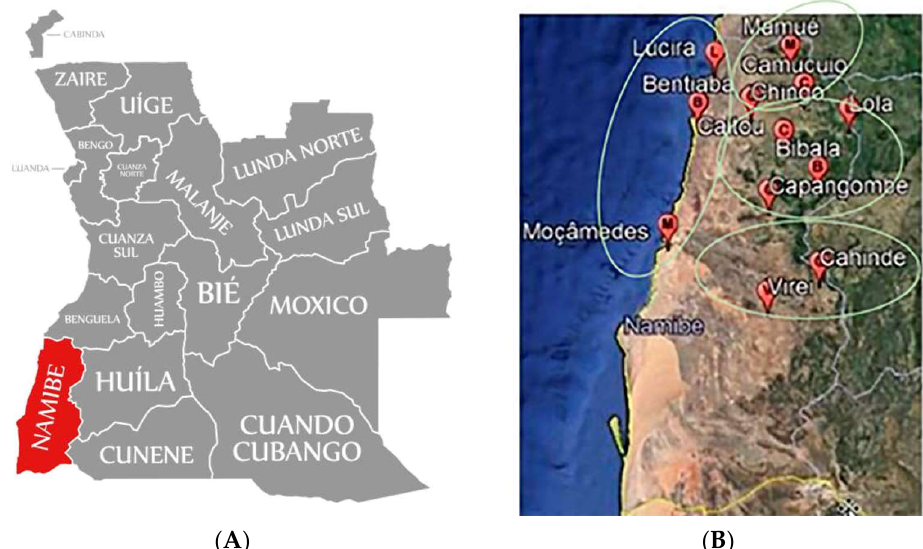
Figure 2. ( A ) Map of the Namibe province in Angola [53] and ( B ) map of sampling locations in four Namibe communities [54]. Table 3. GPS location of the baobab samples collected in Namibe of Angola.